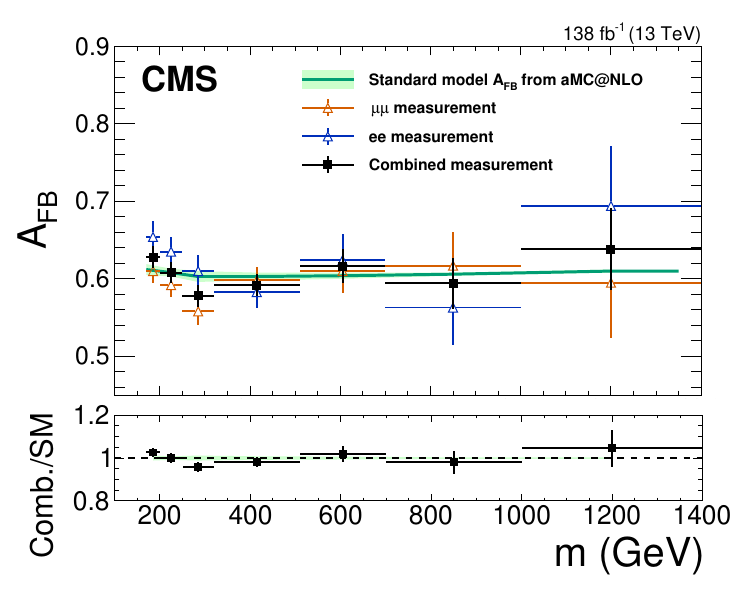
Figure 3 . Measurement of the DY forward-backward asymmetry as a function the dilepton mass compared with the MC predictions. The green line is the predicted value for A a MC@NLO simulation and the shaded green region its uncertainty. The red, blue, and black points and error bars represent the dimuon, dielectron, and combined measurements, respectively. Error bars on the measurements include both statistical and systematic components. The bottom panel shows the ratio between the combined measurement and the a MC@NLO prediction. In the bottom panel, the vertical error bars represent the uncertainty in the combined measurement and the shaded green band the uncertainty in the a MC@NLO